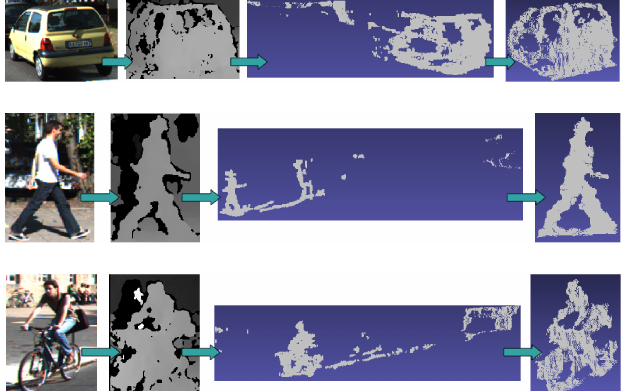
Figure 3. From left to right: Ground-truth color image patches, disparity patches in gray scale, original point clouds recovered from them and manually segmented objects. The point clouds are directly obtained with the reprojected pixels of the object bounding box.